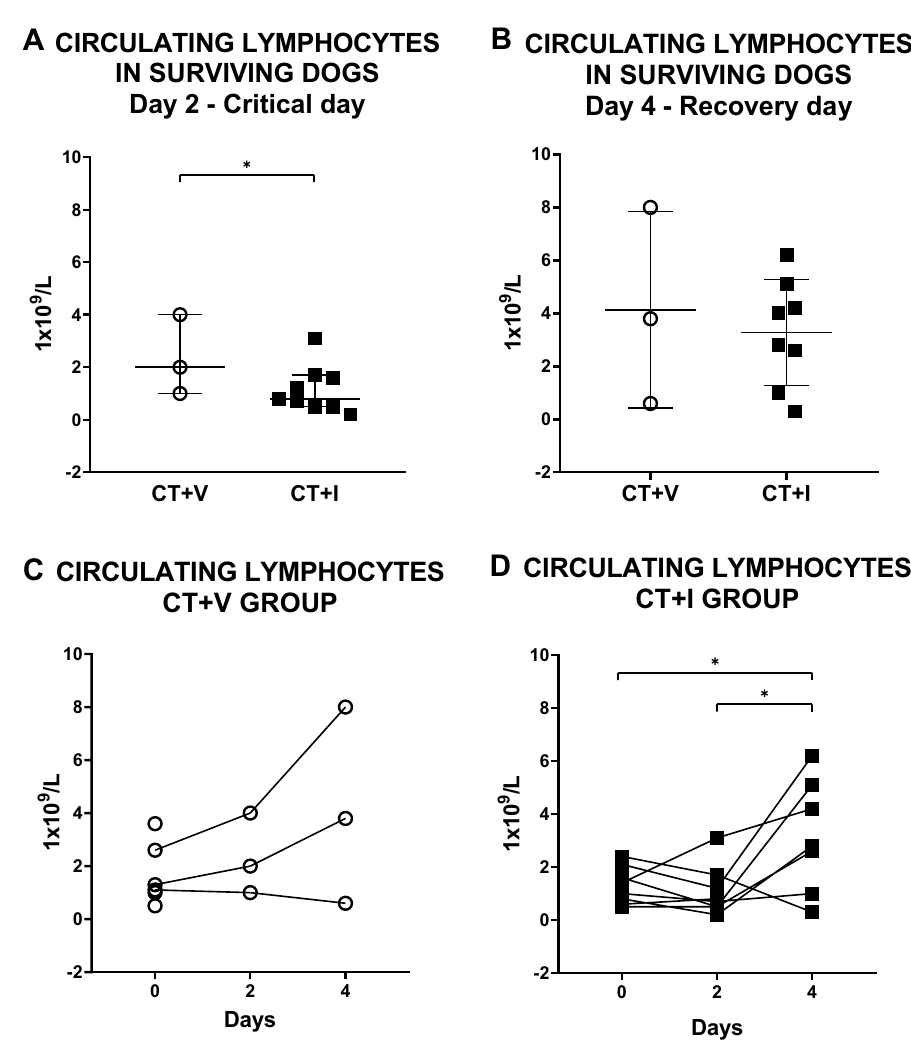
Figure 4. Effect of the immunomodulator over the concentration of circulating lymphocytes of puppies affected by CPE. ( A ) Circulating lymphocytes in surviving dogs on a critical day (day 2) and ( B ) circulating lymphocytes in surviving dogs on recovery day (day 4); there are no statistical differences between groups on day 4; the difference on day 2 is due to the lower lymphocyte values in CT + I vs CT + V. Mann–Whitney test was performed. Each dot represents a puppy. Median ± 5–95% confidence interval. ( C ) Lymphocyte concentrations on day 0, critical day (2), and recovery day (4) in the CT + V group. Lymphocyte concentrations do not show statistical differences at any time evaluated. Kruskal–Wallis test and Dunn’s post-hoc test were done. Each dot represents a puppy. ( D ) Circulating lymphocytes in CT + I group, this group showed differences in recovery time due to an increase in lymphocytes as compared with basal measurement and day 2. One-way ANOVA, Tukey’s post-hoc test. Each dot represents a puppy. Mean ± SD. *P ≤ 0.05. CT conventional treatment, I immunomodulatory, V